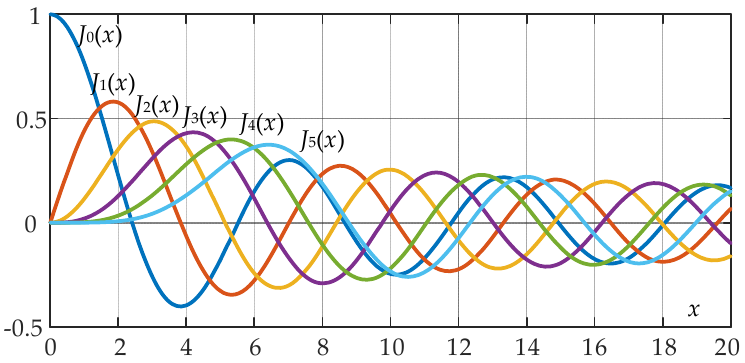
Figure 5. Bessel function curves with different orders.